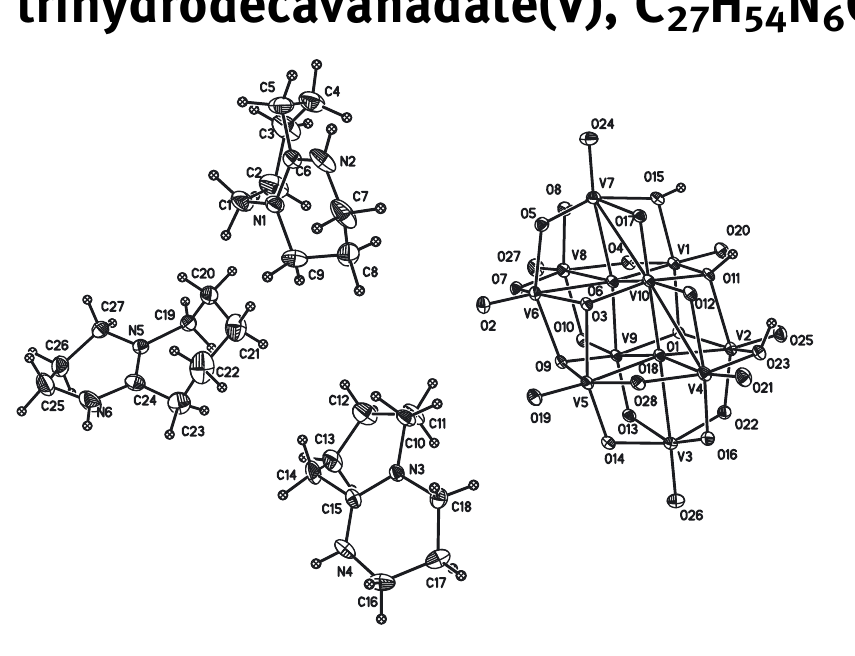
Table  : Data collection and